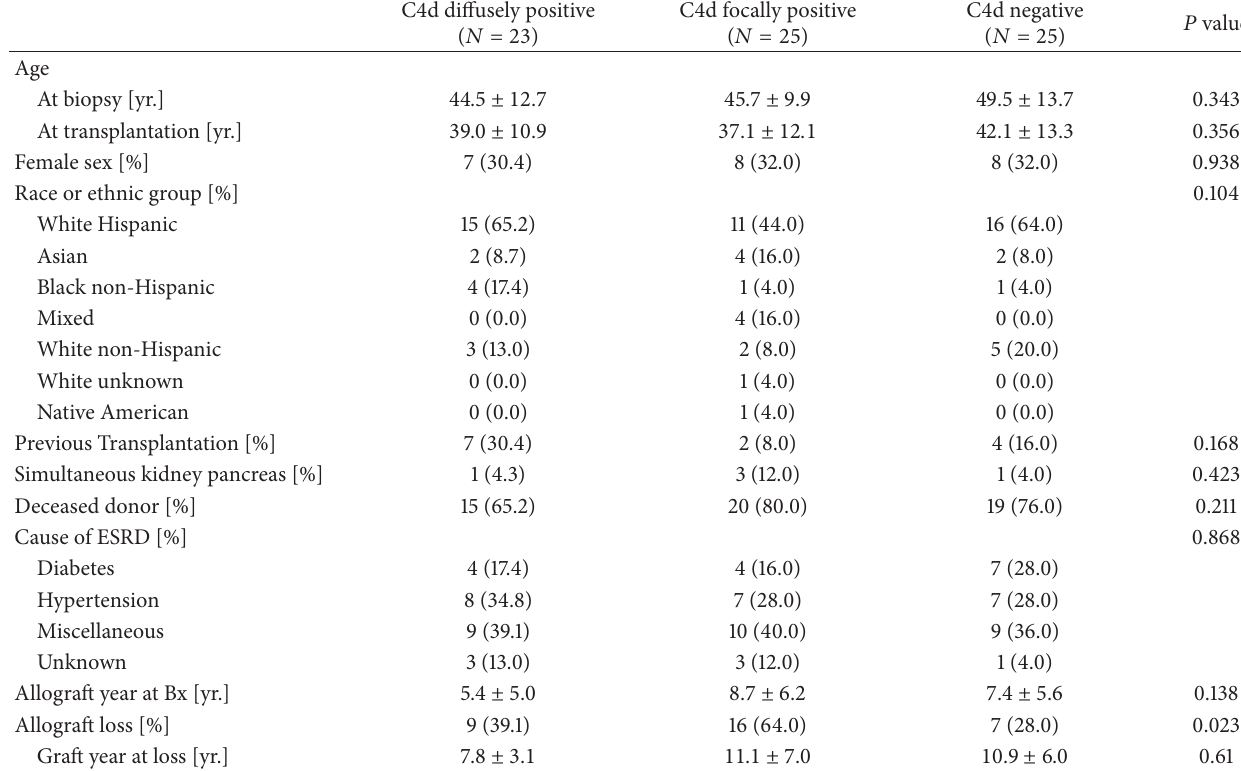
Table 1: Patient